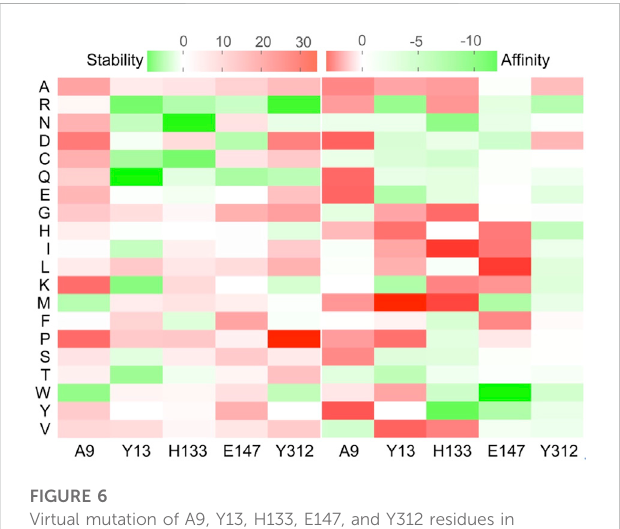
FIGURE 6 Virtual mutation of A9, Y13, H133, E147, and Y312 residues in L -PpTA.